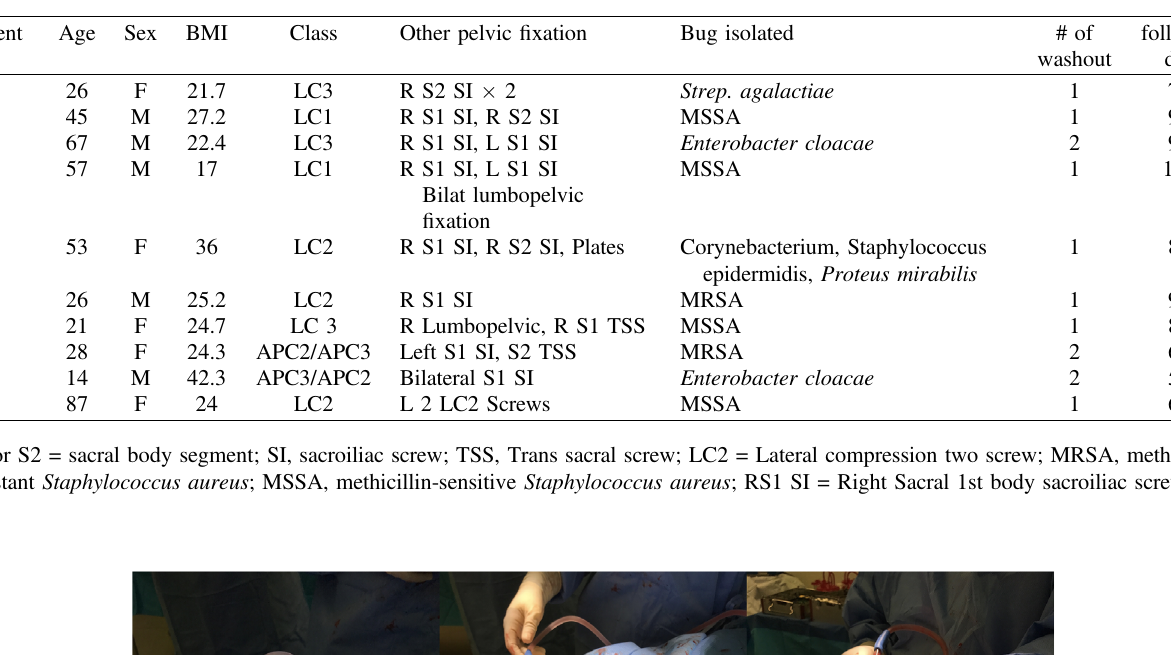
Table 1. Patient demographics.